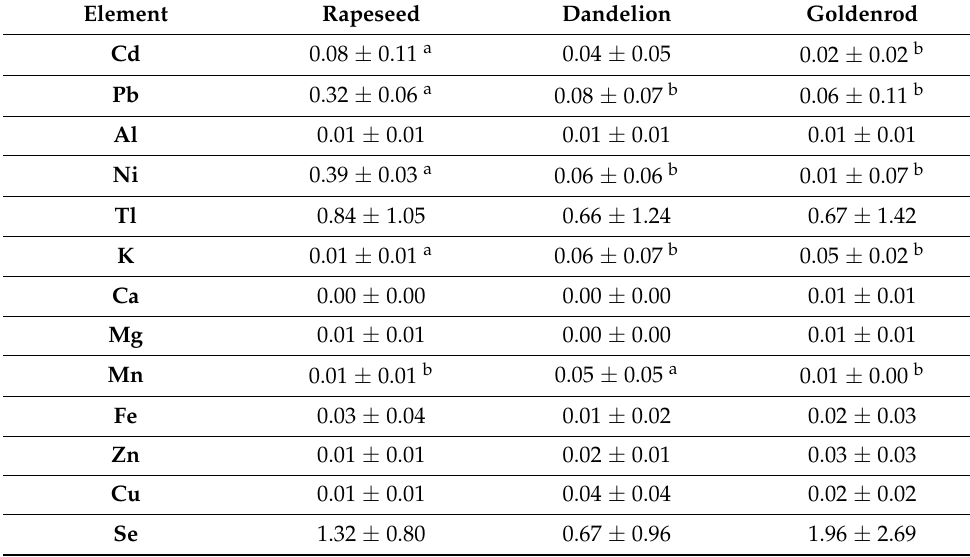
Table 4. Translocation factors calculated for honey samples.